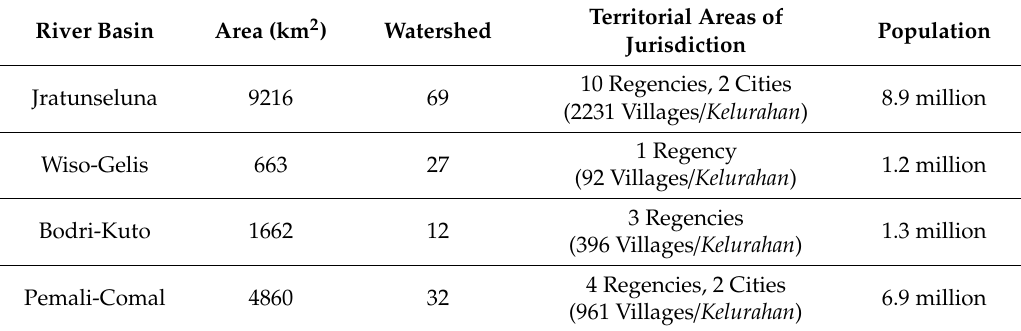
Table 1. River Basins in the Northern Coast of Central Java.